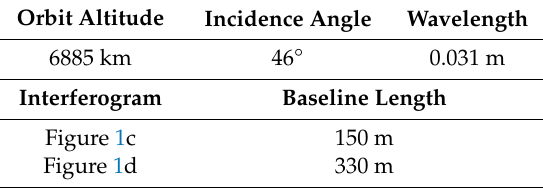
Table 1. Major parameters of simulated InSAR system and Interferograms.